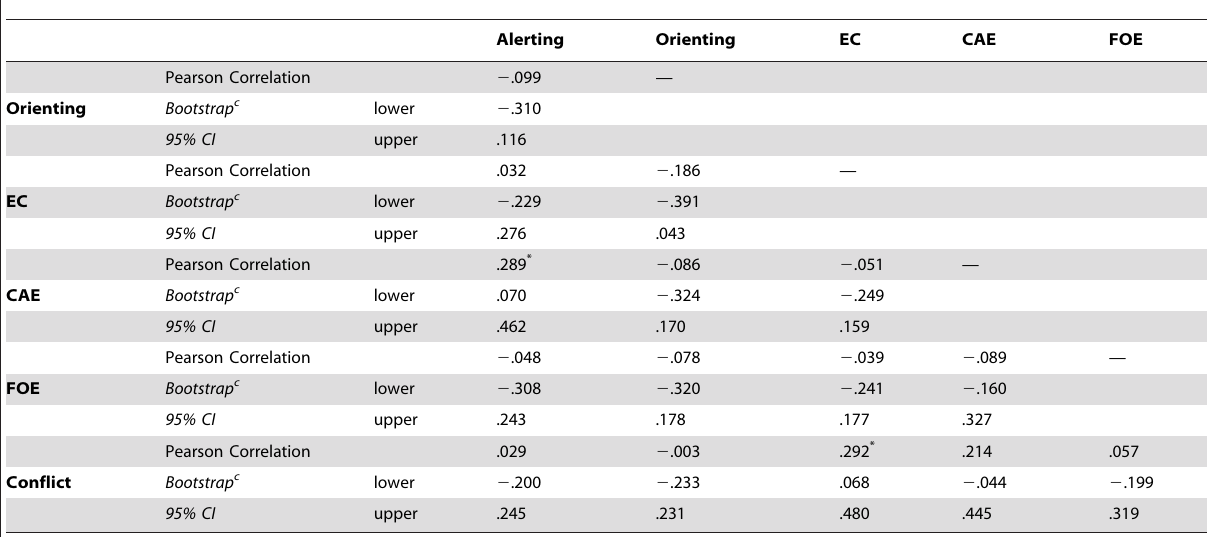
Table 4. Correlations between the related factors in Experiment